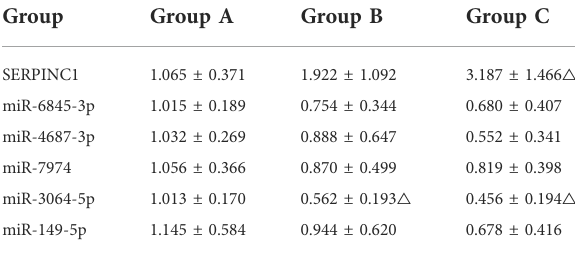
TABLE 6 Expression levels of AT-III miRNA gene and corresponding miRNA in PBMC of patients ( (cid:1) x ± s , n = 10).